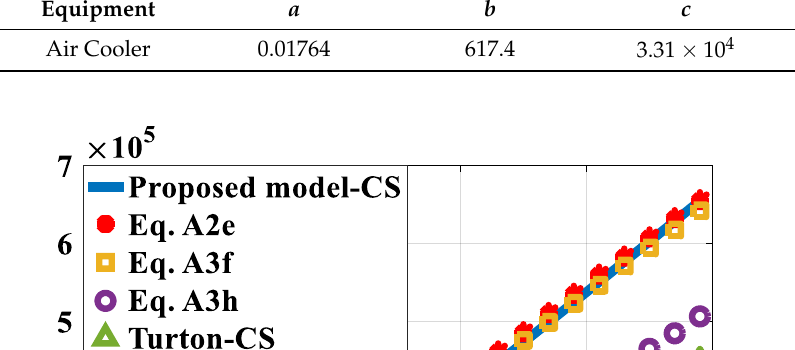
Figure 7. Air cooler cost against area [48]. 𝐶 = 𝑙𝑜𝑔(𝐴) + 𝑎. (𝐴) 2 + 𝑏. 𝐴 + 𝑐 (4) where 𝐴 is compressor power ( m 2 ) and 𝐶 is the cost ( $ ).